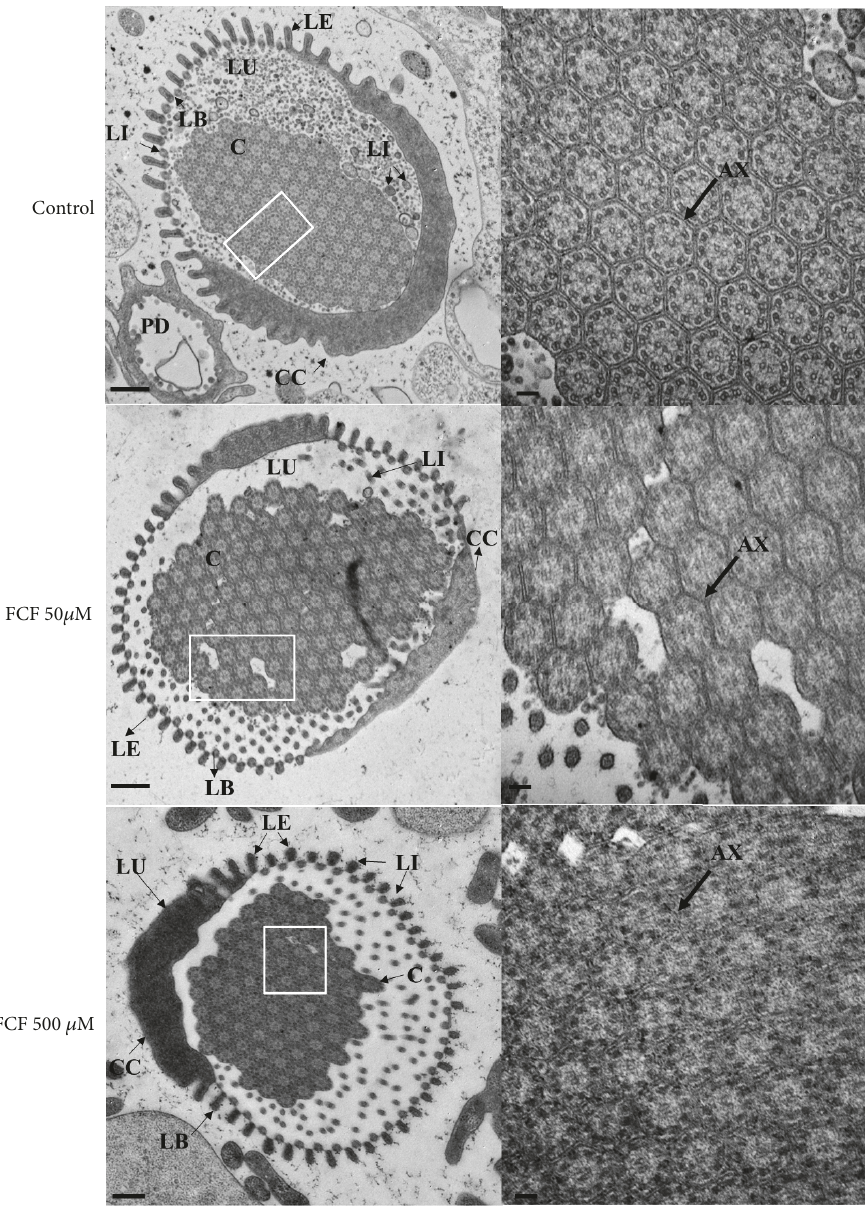
Figure 5: Effect of FCF on the morphology of flame cells visualized by transmission electron microscopy. AX, axoneme; C, cilia; CC, cell channel; LB, basal lamina; LE, leptotrich (external); LI, leptotrich (internal); LU, lumen; PD, protonephridial duct. Scale bar, 2 nm (left), 100 nm (right). Images on the left side show flame cells, with cilia and leptotrich, surrounded by cell channels; images on the right side show the distribution of cilia and the position of the axoneme (indicated by an